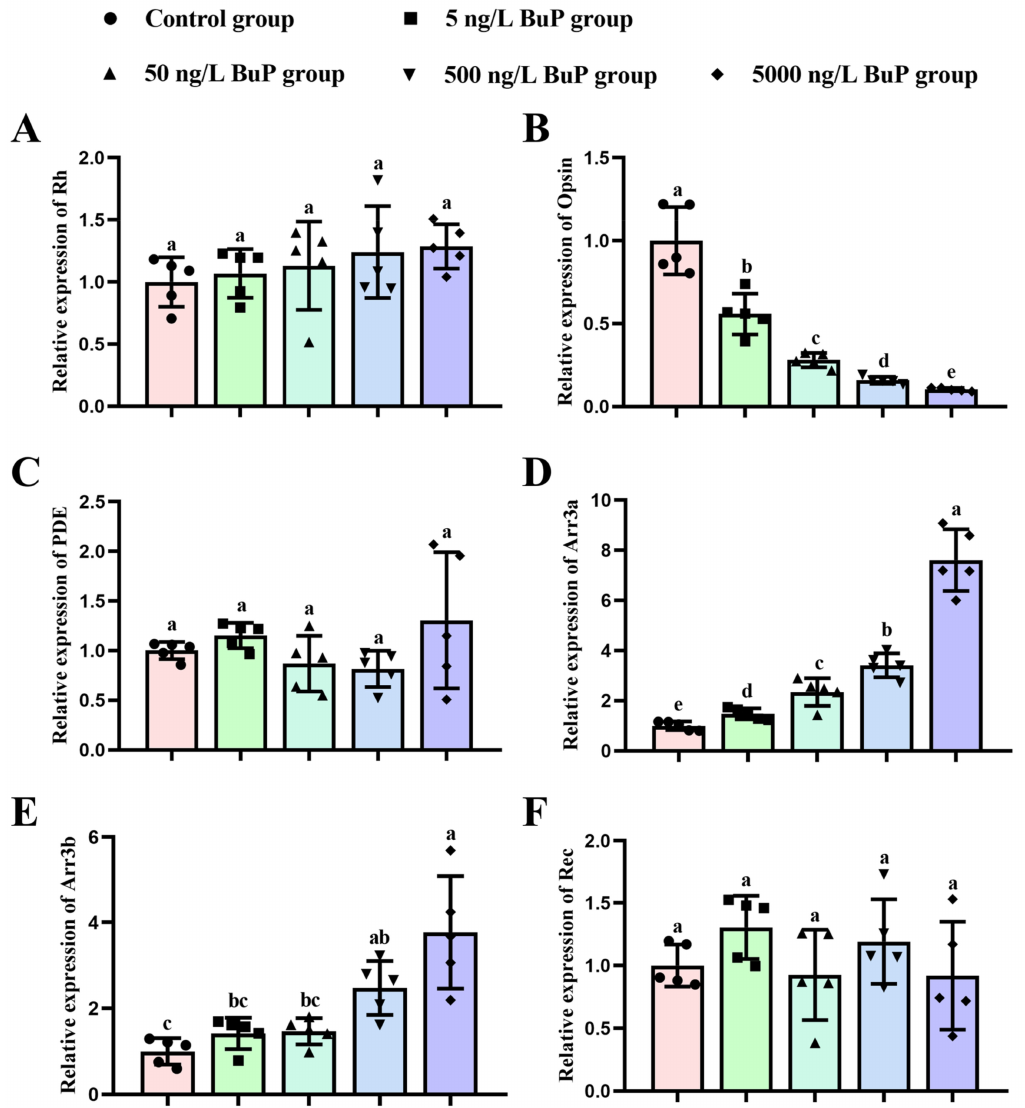
Figure 5. Effects of BuP on the relative expression levels of Rh ( A ), Opsin ( B ), PDE ( C ), Arr3a ( D ), Arr3b ( E ), and Rec ( F ) in eye tissues. Means of groups not sharing a common letter are significantly different at p <